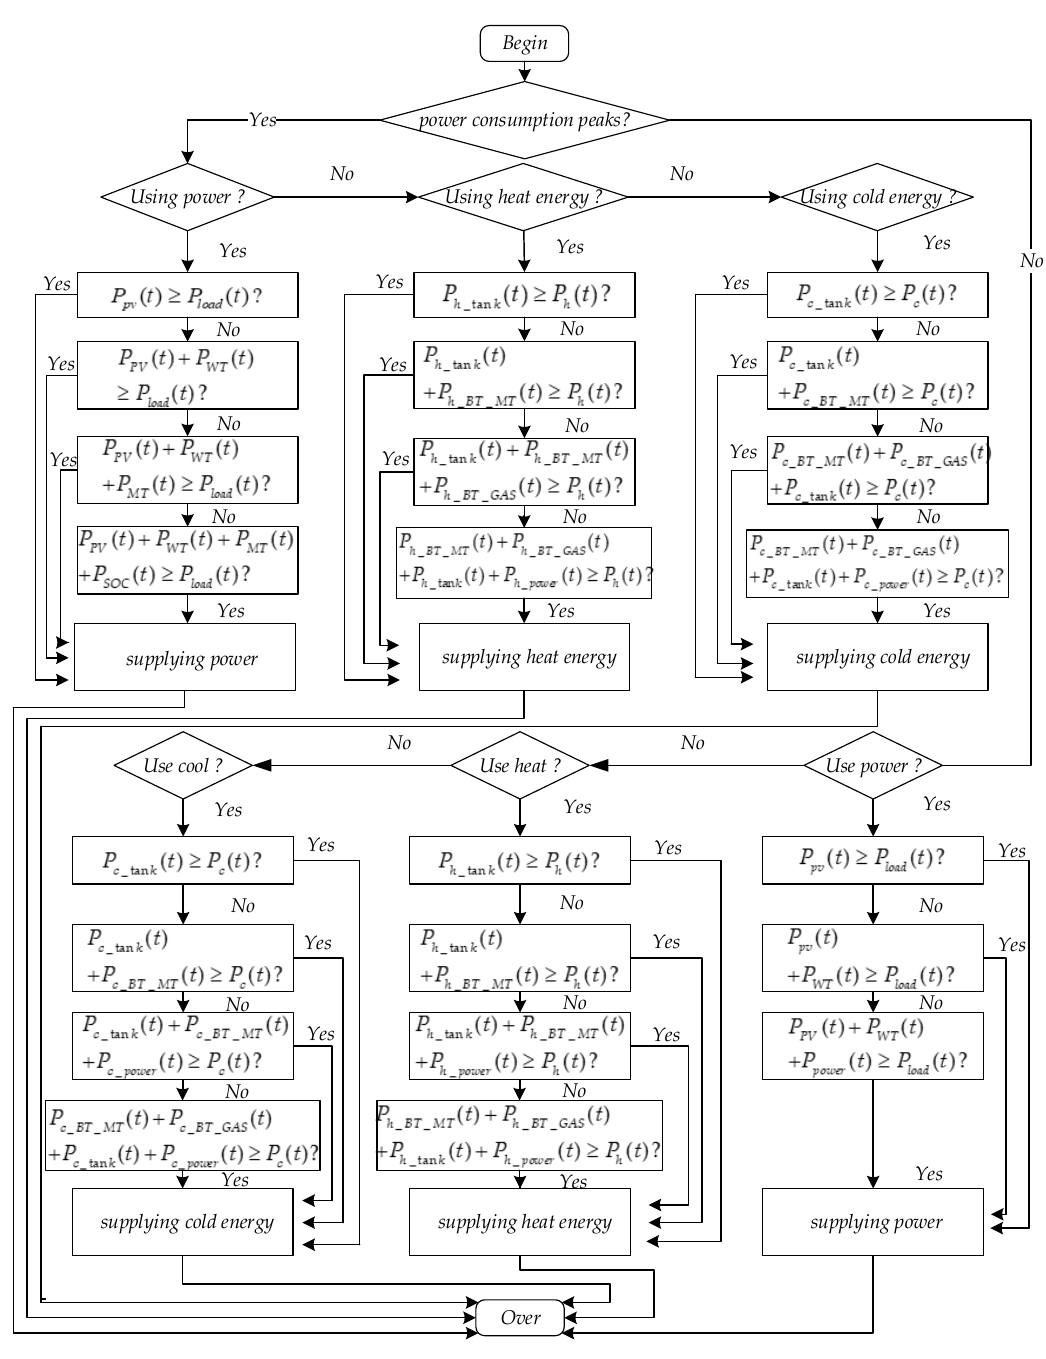
Figure A1. Energy scheduling flowchart of the proposed CCHP system.